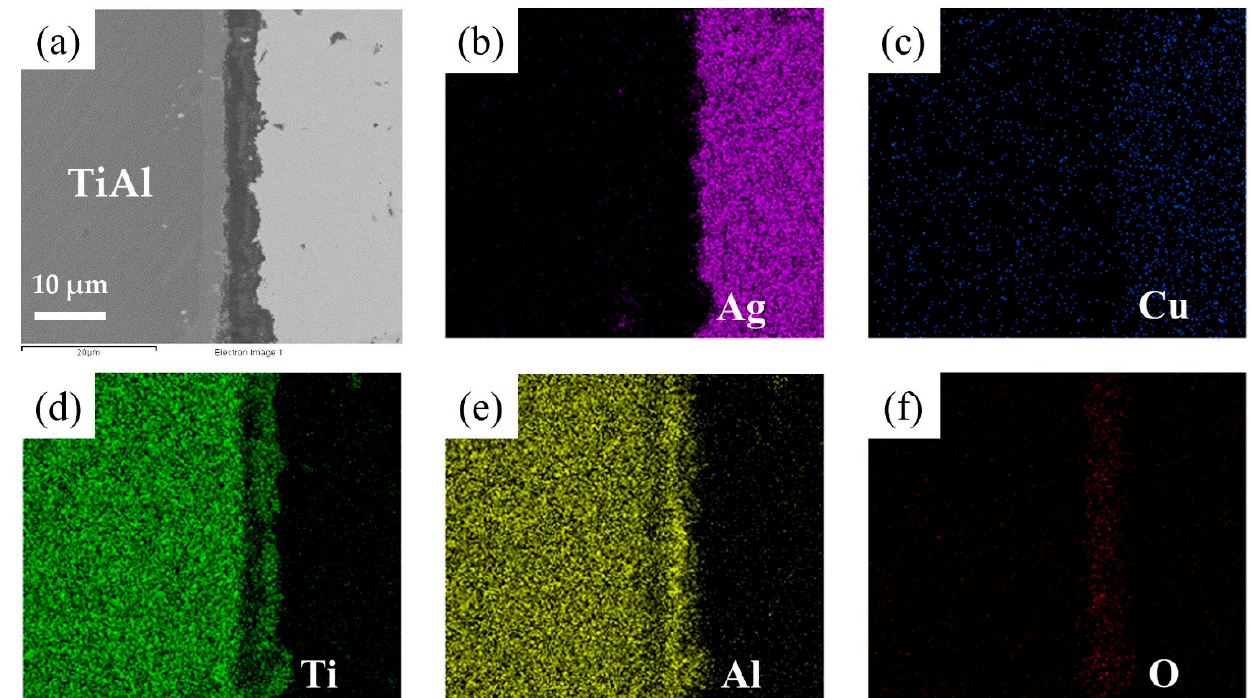
Figure 8. EDS map scanning result of the interface: ( a ) SEM image of the interface. The corresponding EDS maps from Figure 6a: ( b ) Ti, ( c ) Al, ( d ) O, ( e ) Cu, ( f ) Ag.